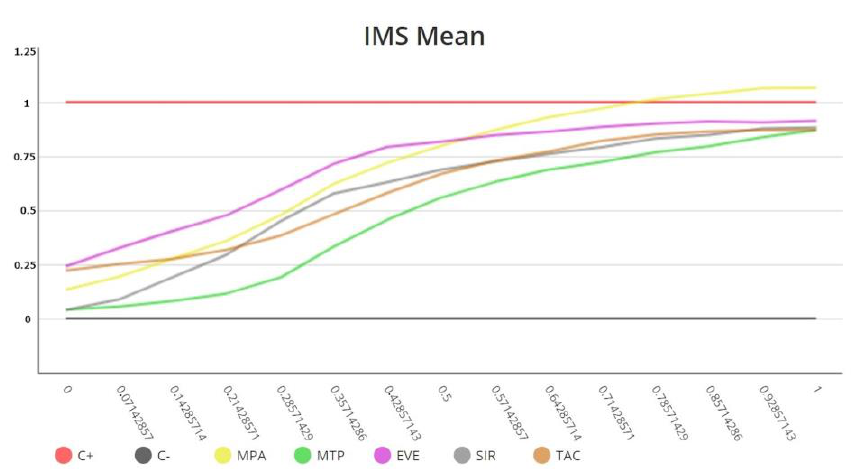
Figure 4. Immunobiogram dose–response curves obtained for a patient. Each immunosuppressive drug is tested in triplicate in the Immunobiogram plate, and the mean value of these measurements (IMS mean) is used to obtain the final curve for each immunosuppressant.